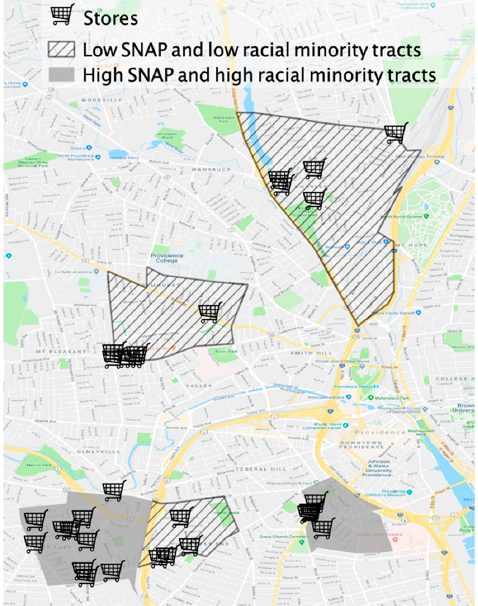
Figure 1. Map of Providence with 15 stores in high SNAP and high racial minority tracts 1 and 15 stores in low SNAP and low racial minority tracts 2